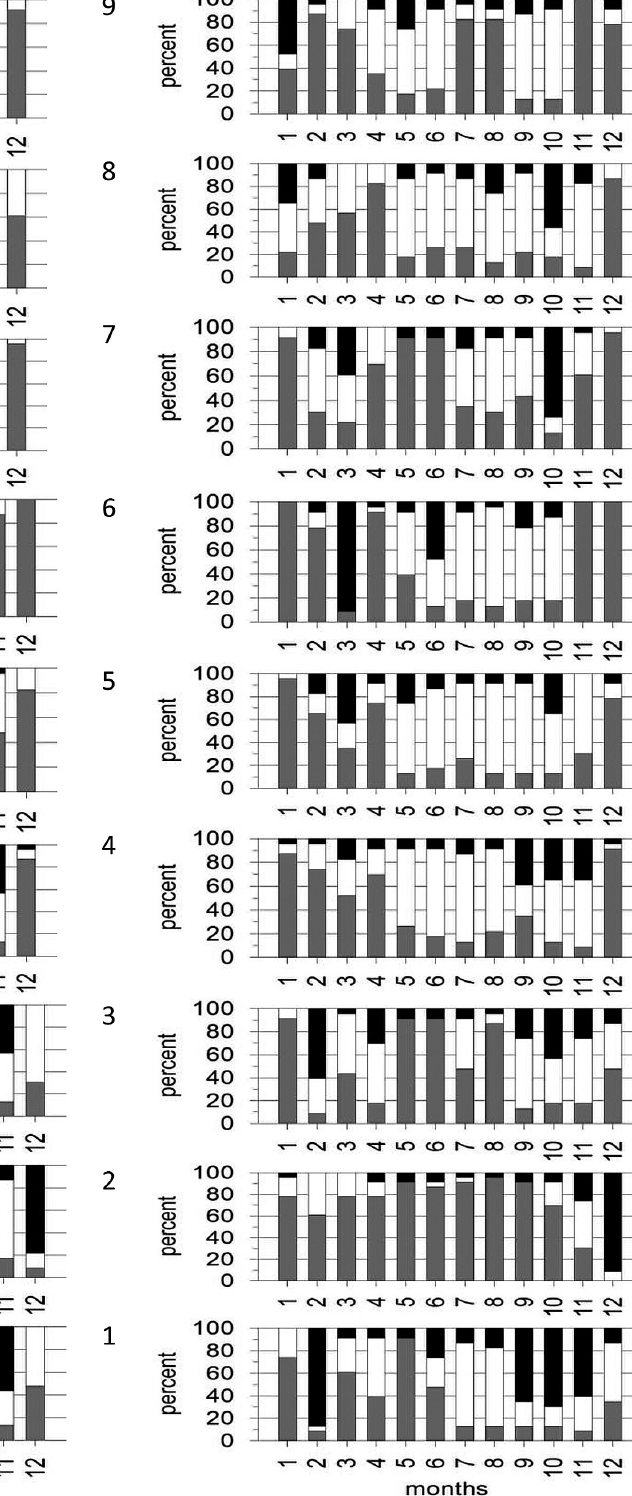
Fig. 8. Frequencies of improvements (grey), no change Fig. 7. Frequencies of improvements (grey), no change (white) and worsening (black) after corrections of the 10th (white) and worsening (black) after corrections of mean percentile made by the DDC method for individual models made by the DDC method for individual models (numbers (numbers the same as in Table the same as in Table 1).